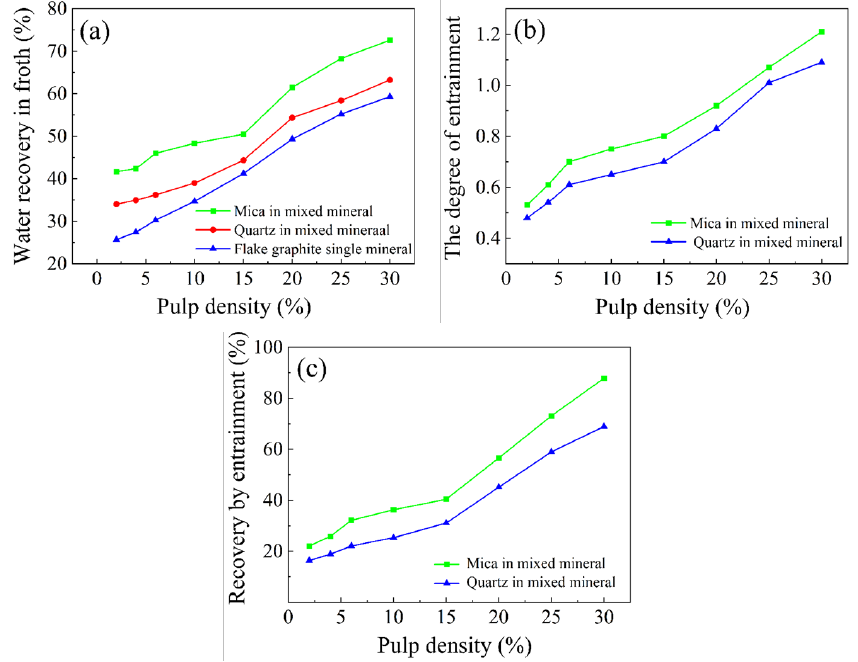
Figure 12. The effect of pulp density on the entrainment of gangue minerals in mixed flotation: ( a ) the water recovery in froth; ( b ) the degree of entrainment; and ( c ) the recovery of gangue by entrainment.